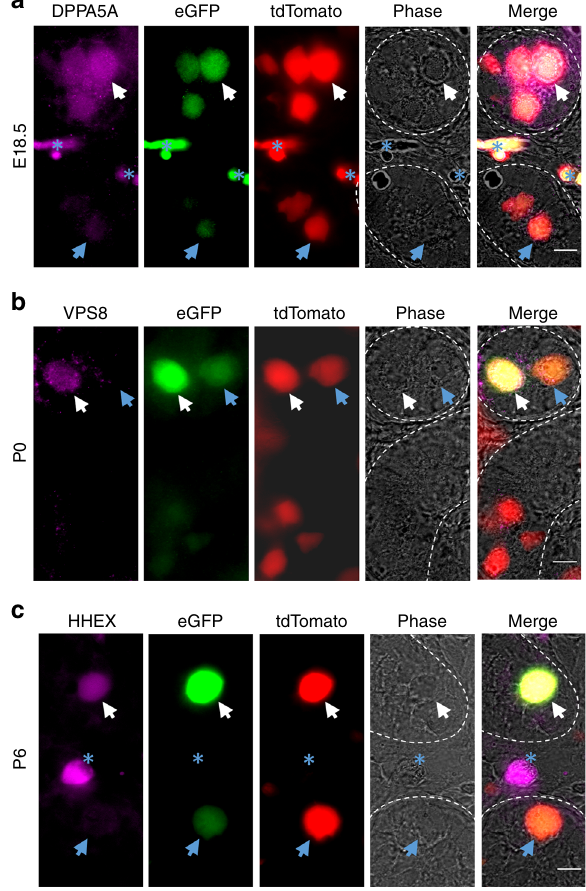
Fig. 5 Validation of markers of SSC fate speci fi cation identi fi ed by scRNA- seq clustering. a – c Immuno fl uorescent staining for DPPA5A ( a ), VPS8 ( b ), and HHEX ( c ) proteins that were identi fi ed as differentially expressed at the transcript level in germ cell clusters 1, 5, and 7 of E16.5, P0, and P6 testes by scRNA-seq, respectively. Immunostaining is overlaid with ID4- eGFP and tdTomato fl uorescence in germ cells. White arrows indicate germ cells that are DPPA5A + and ID4-eGFP + at E18.5, VPS8 + and ID4- eGFP Bright at P0, or HHEX + and ID4-eGFP Bright at P6. Blue arrows indicate germ cells that have low to undetectable staining for the selected marker and ID4-eGFP. Blue asterisks denote in ( a ) vasculature in E18.5 testes that has auto fl uorescence, and in ( c ) an interstitial cell (i.e. tdTomato − ) that is HHEX + . Seminiferous tubule borders are indicated by with white dotted lines. Scale bars, 10 µ m. Images are representative of ≥ 3